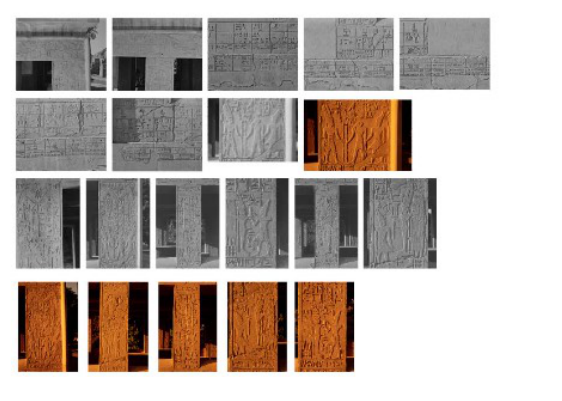
Figure 10 . Photographs of Northern facade from